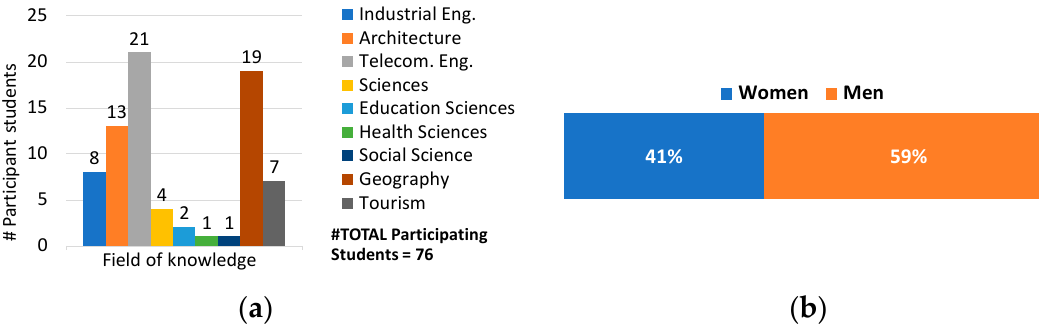
Figure 12. Number of participating students in relation to their area of knowledge ( a ) and gender ( b ).